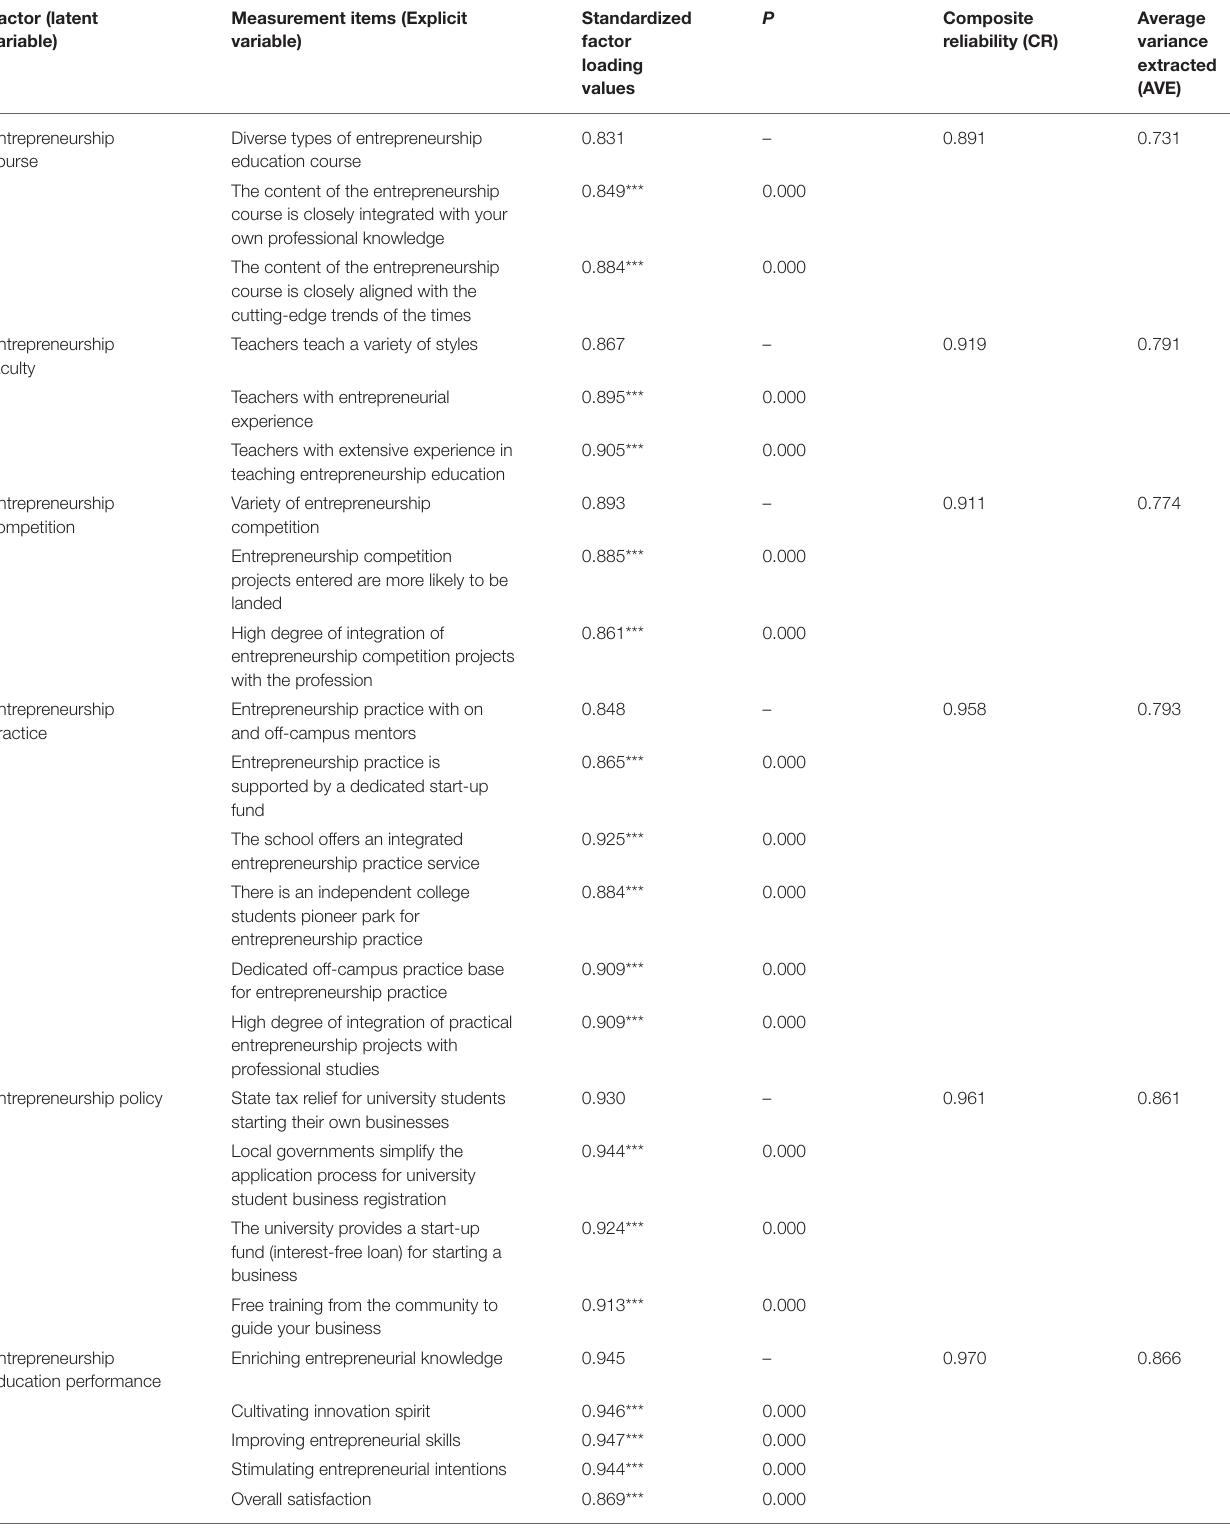
TABLE 2 | Validation factor analysis. Factor (latent